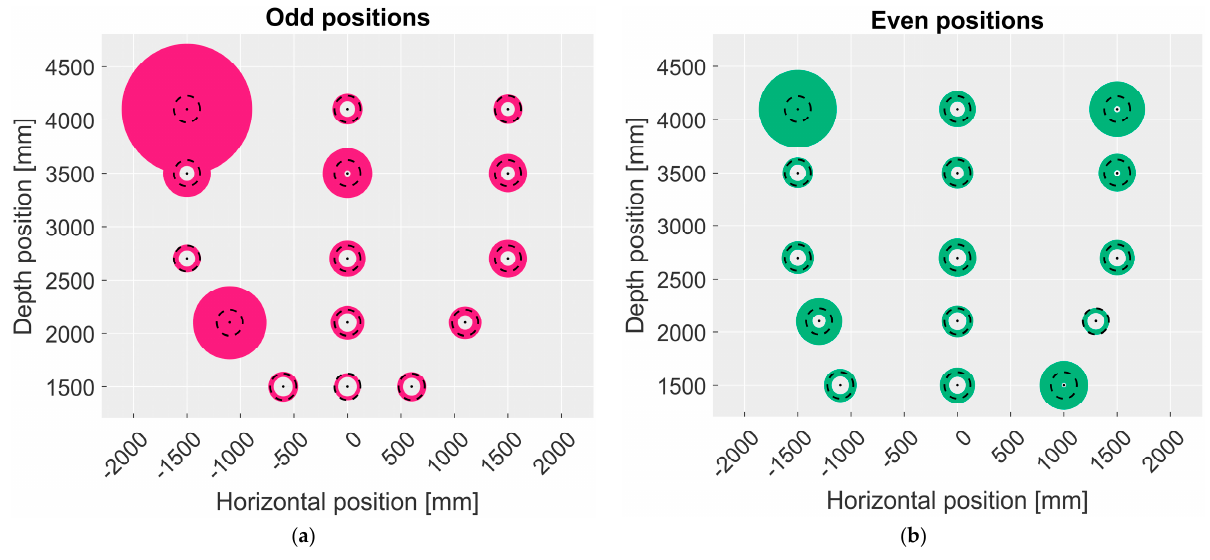
Figure 8. Image showing the upper bound of the cylinder’s diameter as the dimension of the colored circle, and the lower bound as the dimension of the white circle that results for each odd station. The dashed black circle represents the reference diameter. ( a ) Odd positions, ( b ) even positions.